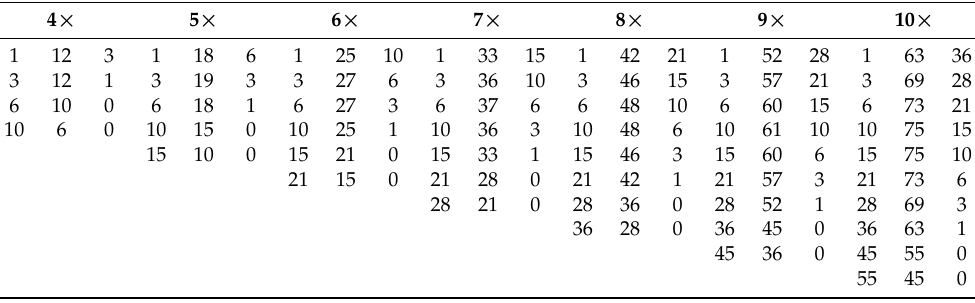
Table 1. Interpolation coefficients of different interpolation multiples.